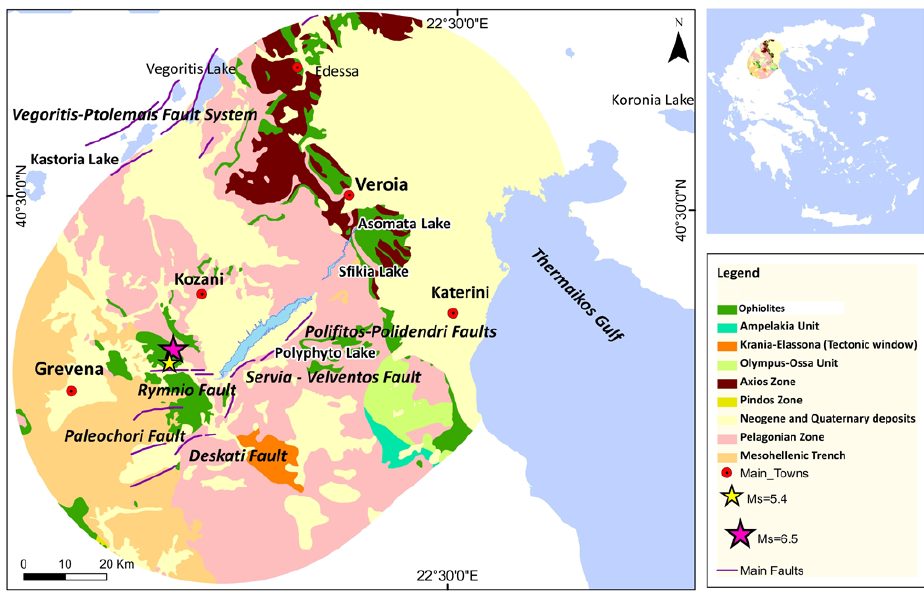
Fig. 1. Map of the main geotectonic and fault zones of the broader area (50km around the artificial lakes). A location map of the region is shown (upper right). Yellow and purple stars denote the epicenters of the 25 October 1984 and 13 May 1995 earthquakes, respectively.